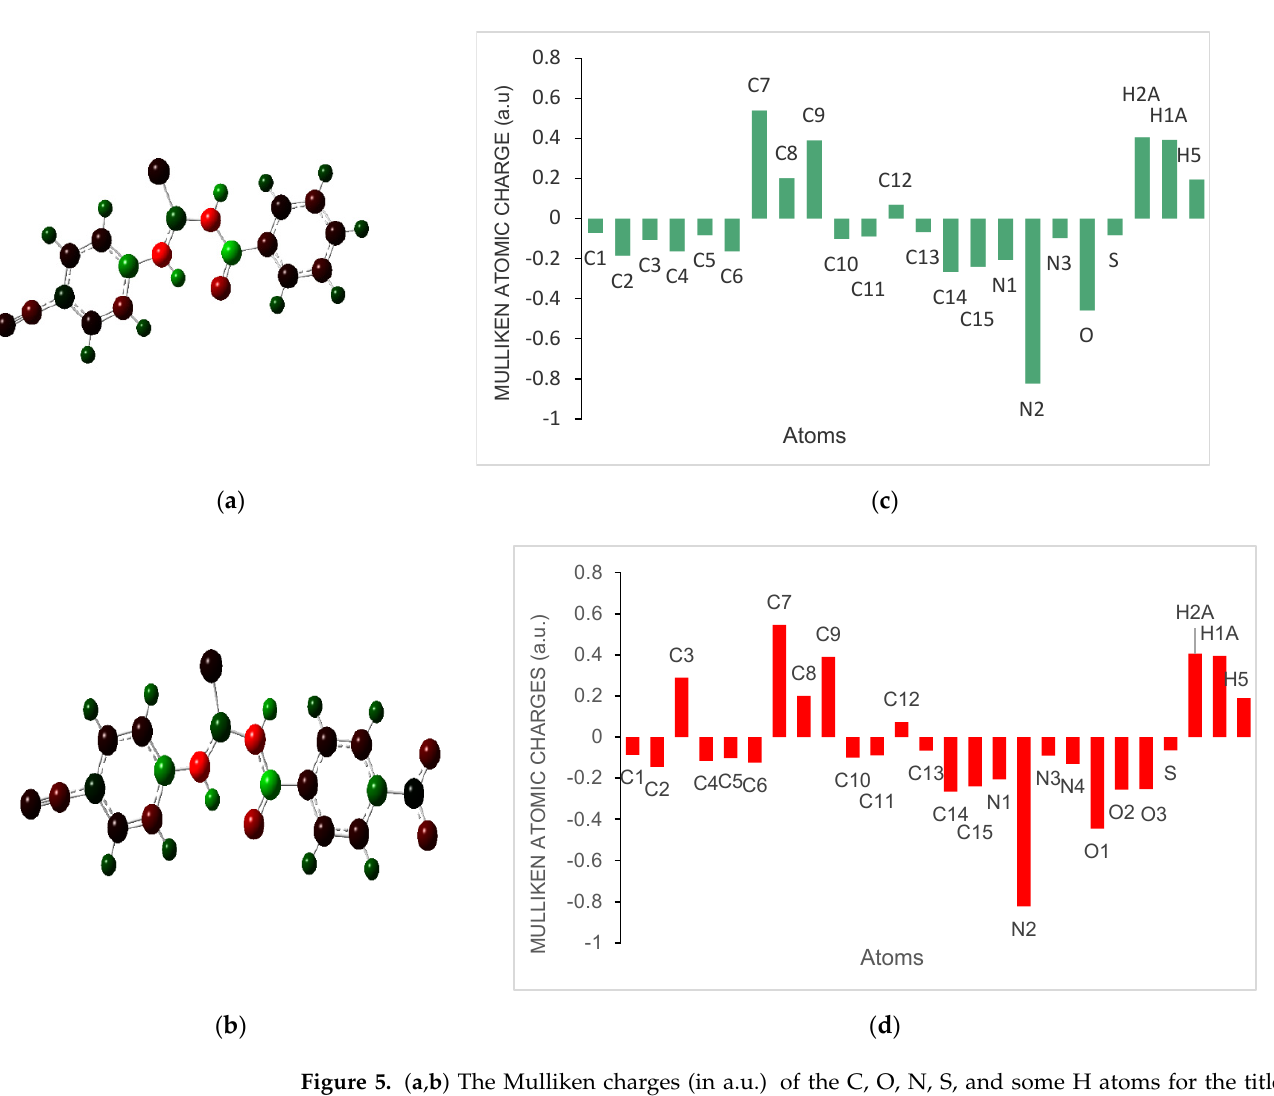
Figure 5. ( a , b ) The Mulliken charges (in a.u.) of the C, O, N, S, and some H atoms for the title compounds 1 and 2 were calculated by DFT B3LYP/6-311G (d,p) basis set; ( c , d ) The graphical representation of Mulliken atomic charge distributation in the title compounds 1 and 2 , respectively.